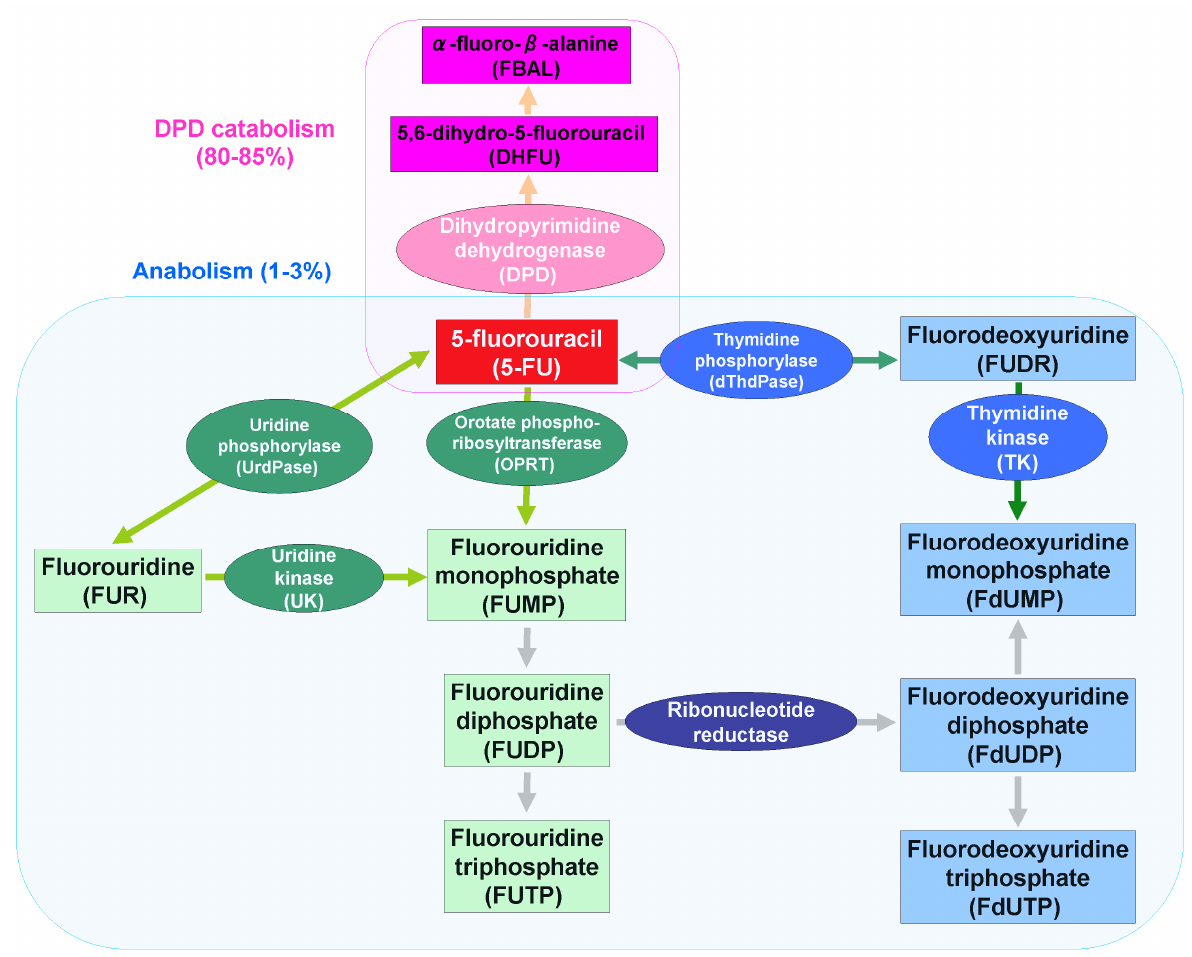
Figure 1. 5-FU anabolism and